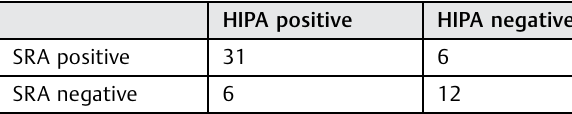
Table 2 Comparison of HIPA and SRA